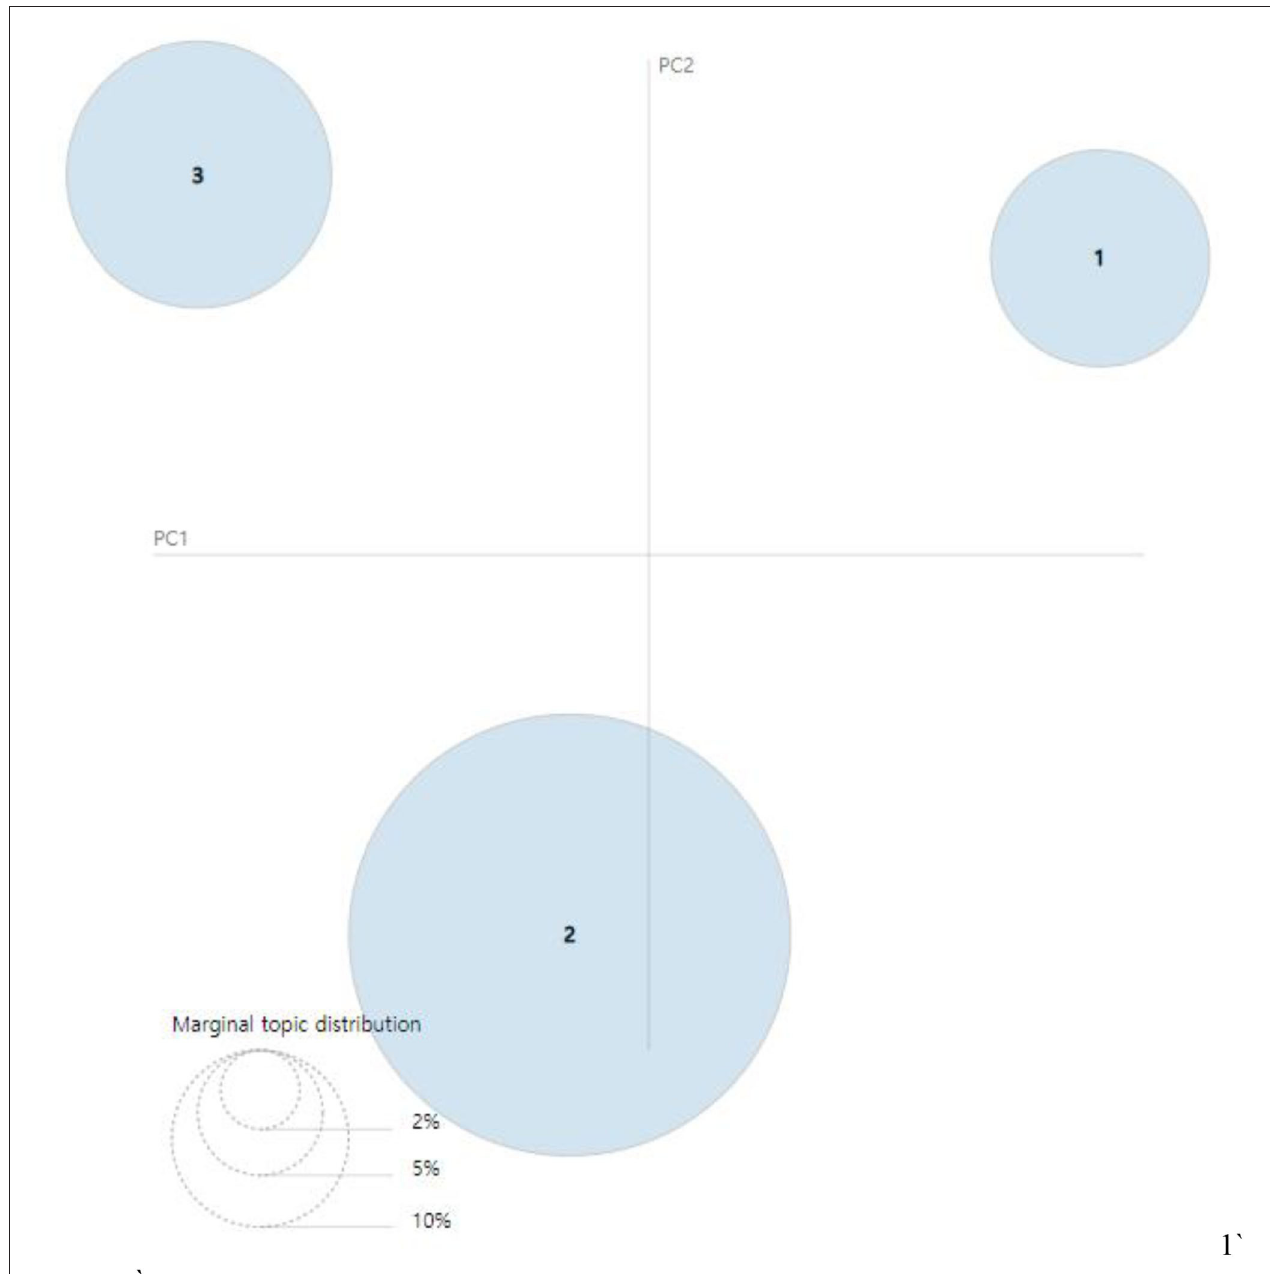
FIGURE 9 | Visualization results of inter-topic distance map via multidimensional scaling (MDS) (2016–2018)